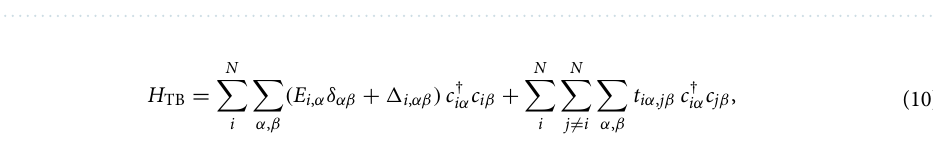
Figure 1. (Color online) Electron (conduction band) g-factor in a bulk InAs as a function of k along the [111]-direction ( a ). The bottom panels present g ( k ) obtained from k · p model, in cross-section on the ( b ) xy -, and ( c ) xz